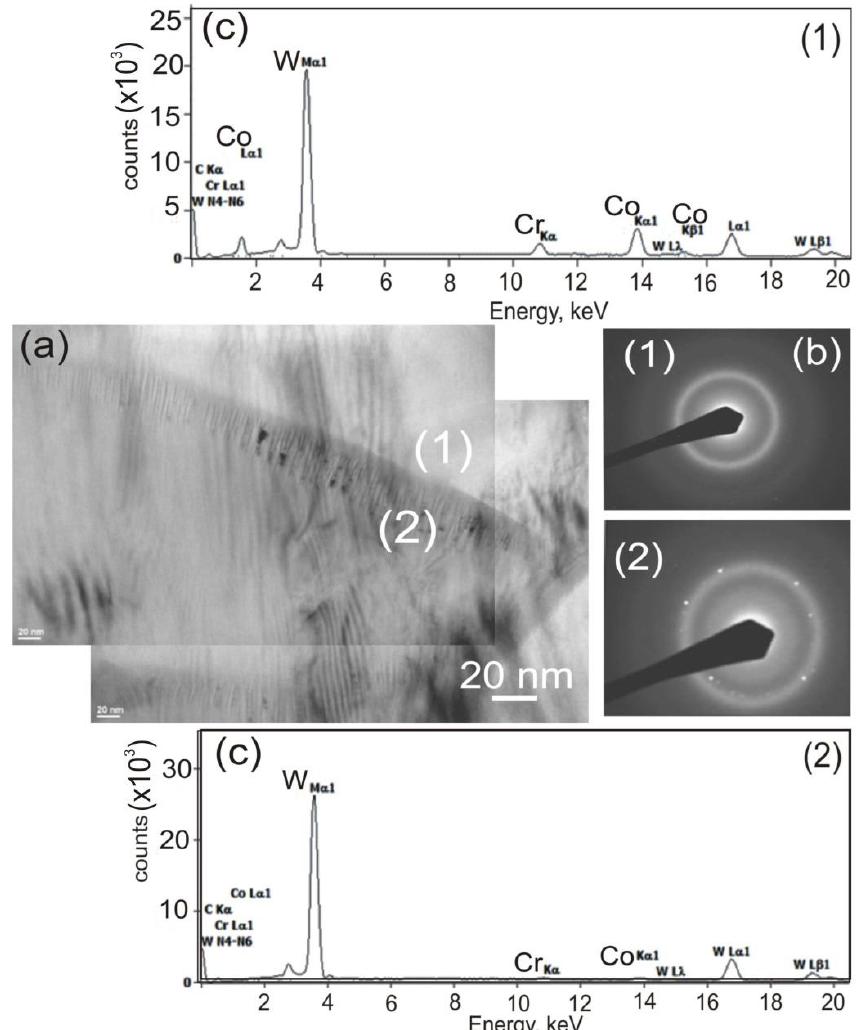
Figure 5. TEM analysis of the composite coating (WC – Co + Cr) deposited on ductile cast iron: ( a ) TEM image; with representative ( b ) area diffraction pattern indicates the formation of nanocrystalline structure; and with corresponding ( c ) EDS spectra taken from the marked points.